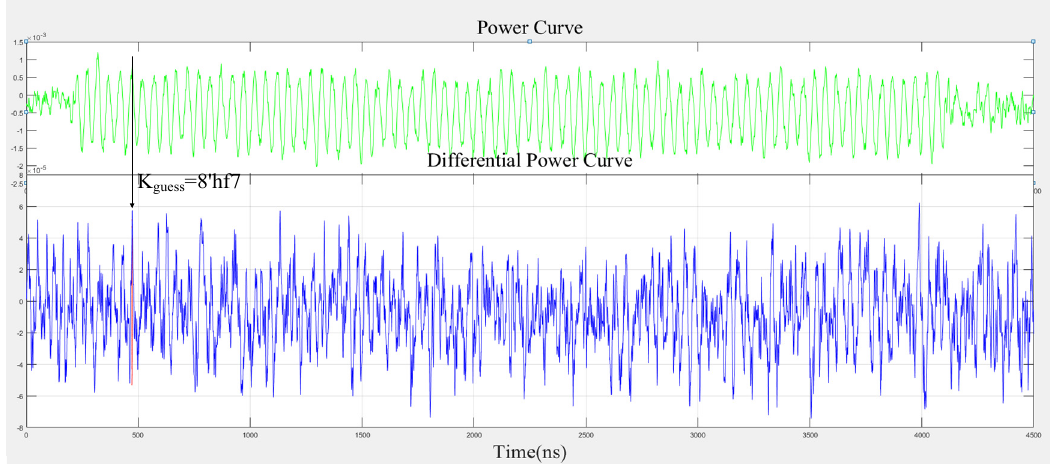
Figure 7. Differential Power Analysis (DPA) curve of the high 8-bit output of the first round of transformation byte replacement operation.